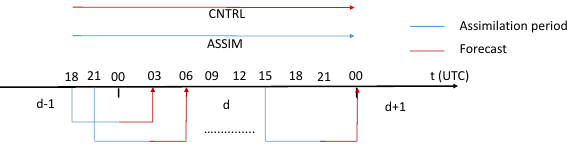
Figure 2. Synopsis of the simulations F3HA6 (below the timeline). The blue line is the assimilation stage, while the red line is the fore- cast stage; d , d + 1, and d − 1 are the actual day, the day after, and the day before the actual day, respectively. In the upper part of the figure the CNTRL and ASSIM simulations are